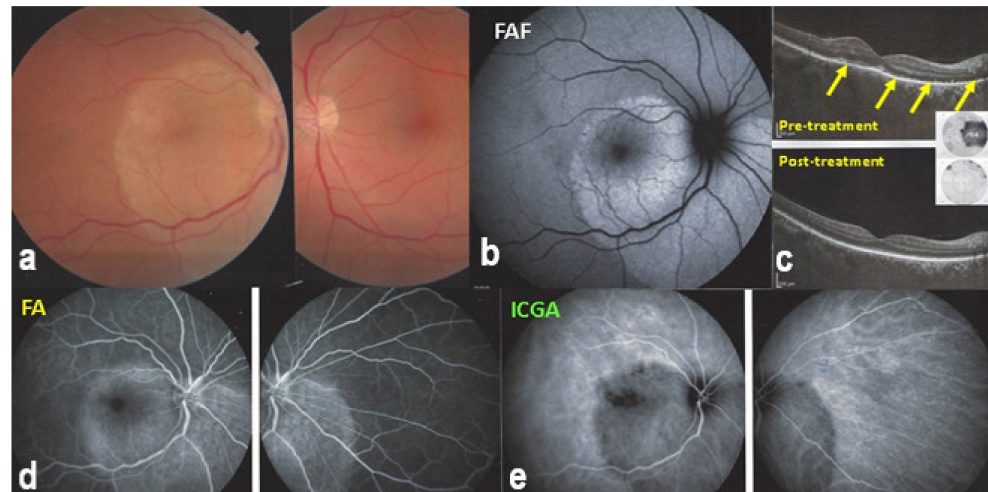
Figure 28. ASPPC (Acute Syphilitic Posterior Placoid Choroiditis) Posterior placoid lesion ( a ), hyperautofluorescent (FAF, ( b )) due to loss of photoreceptor outer segments (OCT—( c )) and better visualization lipofuscin in RPE. On FA, the placoid lesion is hyperfluorescent due to ischaemia of outer retina because of choriocapillaris non-perfusion appearing hypofluorescent on ICGA ( d , e ). SD-OCT ( c ) shows loss of photoreceptor outer segments (yellow arrows) corresponding to visual field loss (insert c-top ). On the lower post-treatment SD-OCT, outer segments reconstitute with improvement of visual field (insert, c-bottom ).